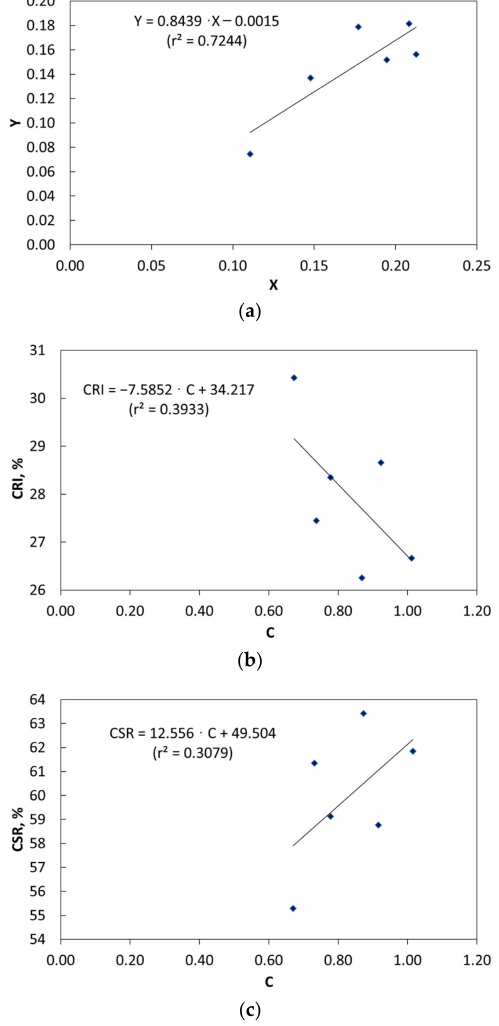
Figure 12. Coke quality dependence of grain distribution constant, C for D g = 5 mm: ( a ) grain triangle acc (14), sl = 0.0316, ( b ) CRI vs C, and ( c ) CSR vs